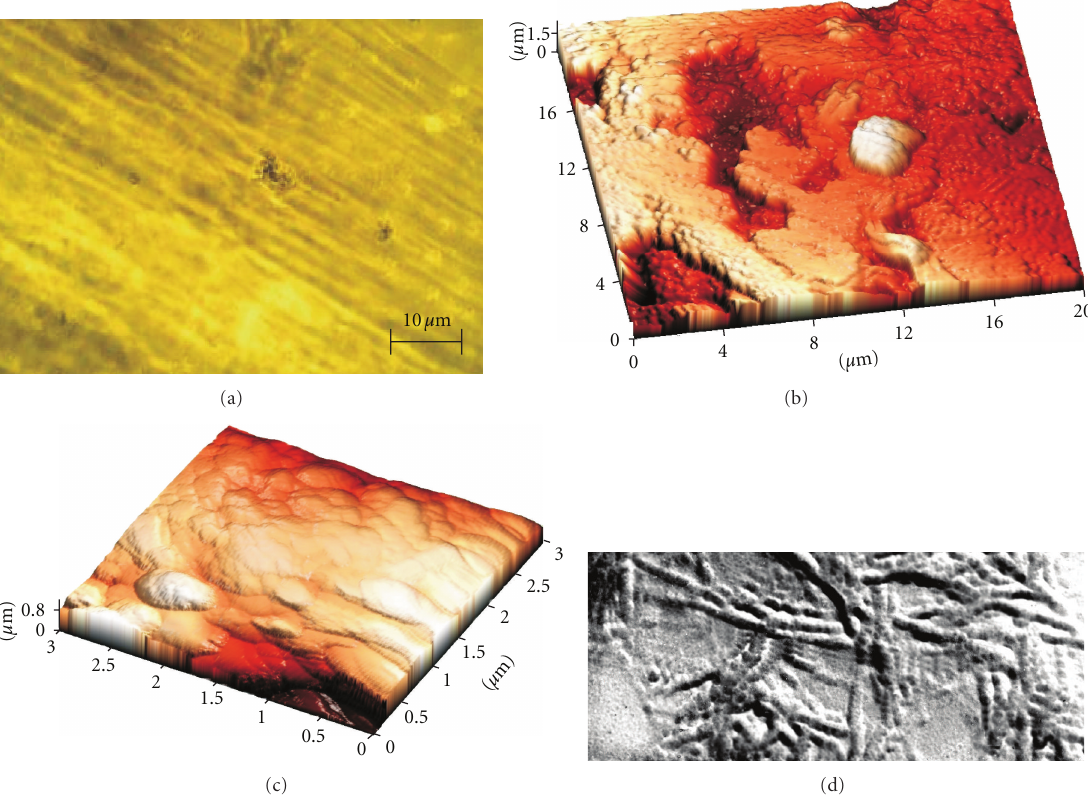
Figure 10: Morphology of the sediment obtained from the anisotropic CTA—nitromethane system by precipitation to ethanol (a)–(c) and by spraying onto mica (d): (a) is the structure of the source sediment in polarized light under crossed Polaroids; (b), (c) are the topographical image (scanning microscopy) of the surface (20 × 20 and 3 × 3 μ m, resp.) of the same sediment (a) dried at room temperature; (d) is the structure of the sprayed sediment (electronic